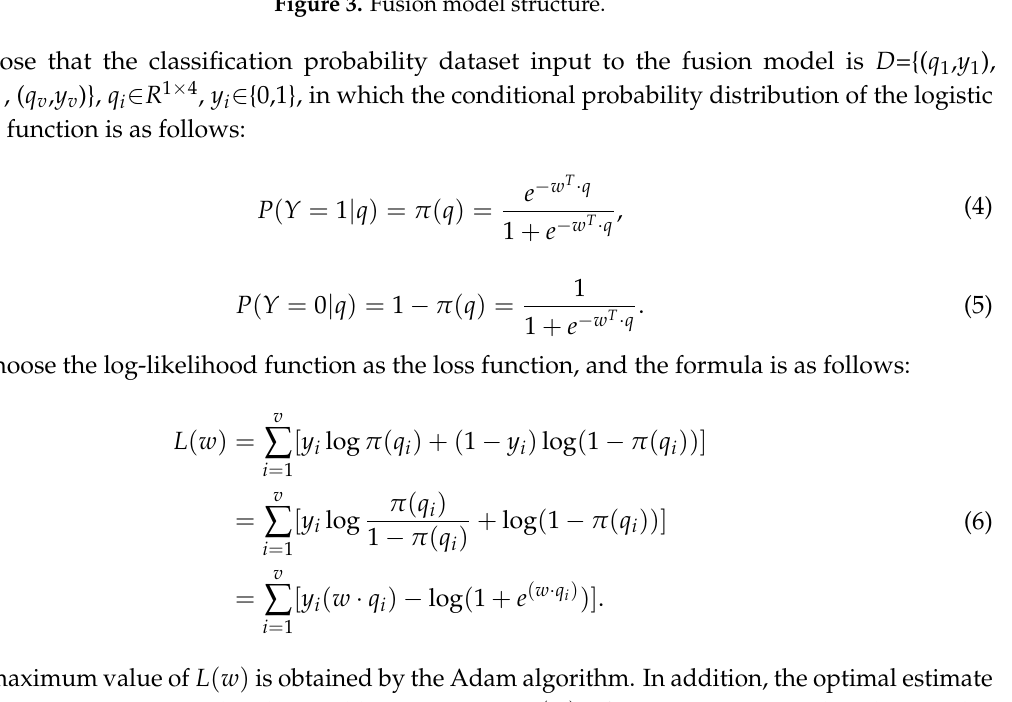
Figure 3. Fusion model